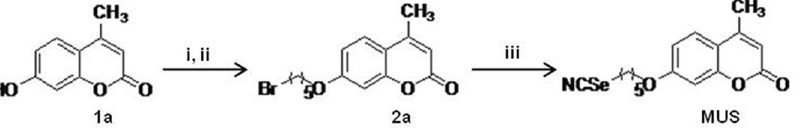
Figure 6. Synthesis of MUS-reagents and conditions. (i) anhydrous potassium carbonate, dry acetone, refluxed for 2 h under N 2 ; (ii) 1,5-dibromopentane, reflux 9 h (iii) KSeCN, 48 h,